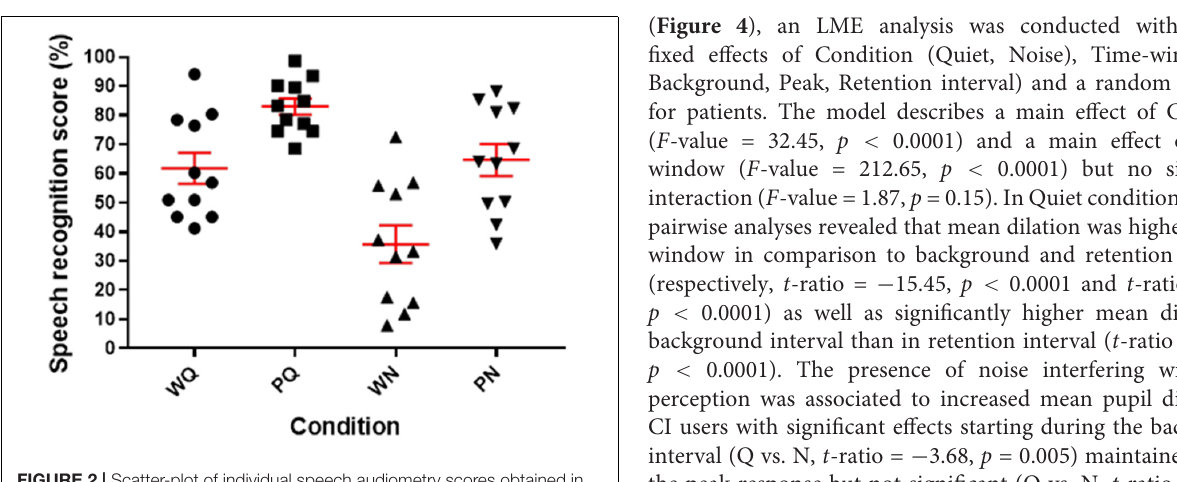
FIGURE 2 | Scatter-plot of individual speech audiometry scores obtained in quiet (Q) and in noise (N) percent correct identification scores for Lafon words (W) and phonemes (P), in red: mean and standard error of mean.